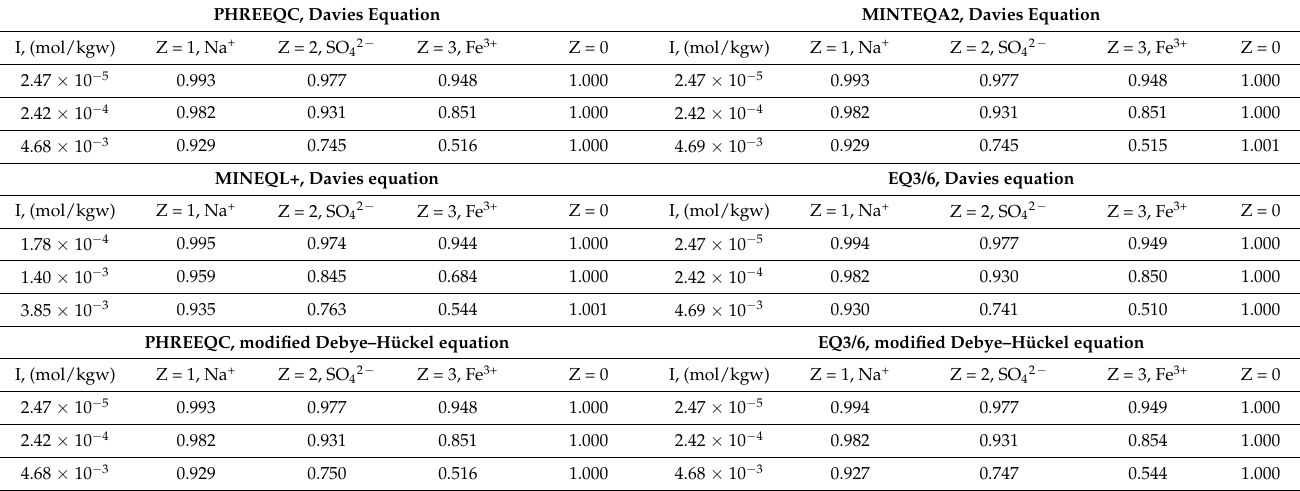
Table 10. Activity coefficients using the Davies or modified Debye–Hückel equations for the four models. PHREEQC, Davies Equation MINTEQA2, Davies